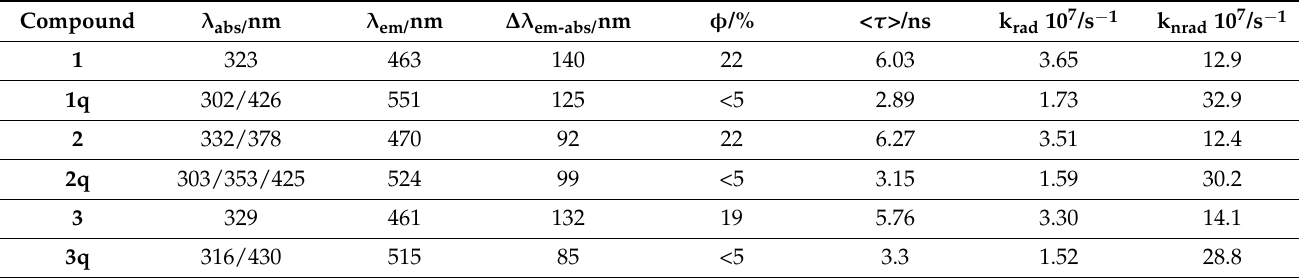
Table 1. Photophysical characterization in DCM solution (concentration 10 − 5 M) of the reported compounds.